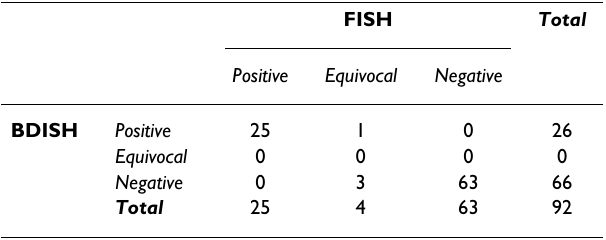
Table 2: Performance of brightfield double in situ hybridization (BDISH) with clinical samples based on the ASCO/CAP